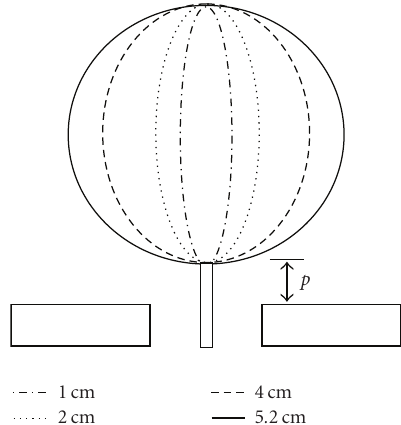
Figure 4: PEMAs with 2 A = 4 . 8cm and 2 B equal to (— - —) 1 cm, (- - - -) 2cm, (– – –) 4cm, and (—–)